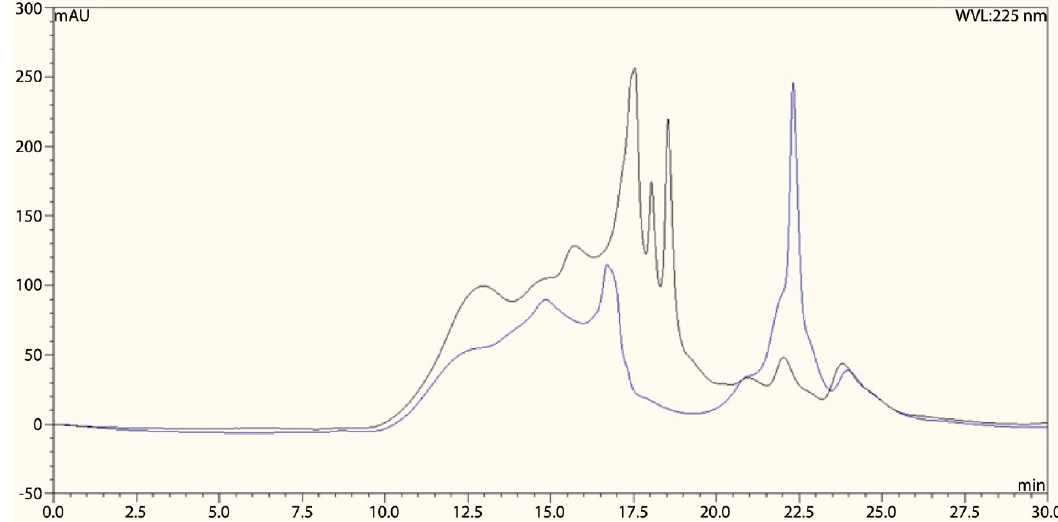
Figure 2. Chromatogram of Pleuran CCWE analysis by high-performance liquid chromatography (HPLC)-SEC (ultraviolet (UV) detection λ = 225 nm); Black: native Pleuran CCWE; blue: Pleuran CCWE after NaOH treatment. The profiles shown are representative of two independently obtained